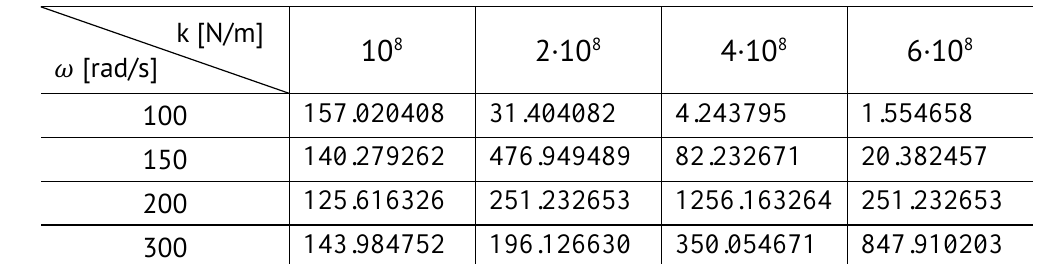
Experimental parameter